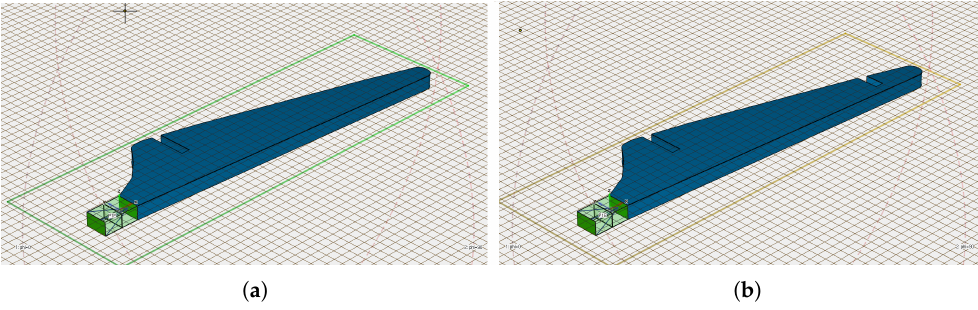
Figure 7. The simple blade design with cracks: ( a ) one crack; ( b ) two cracks.